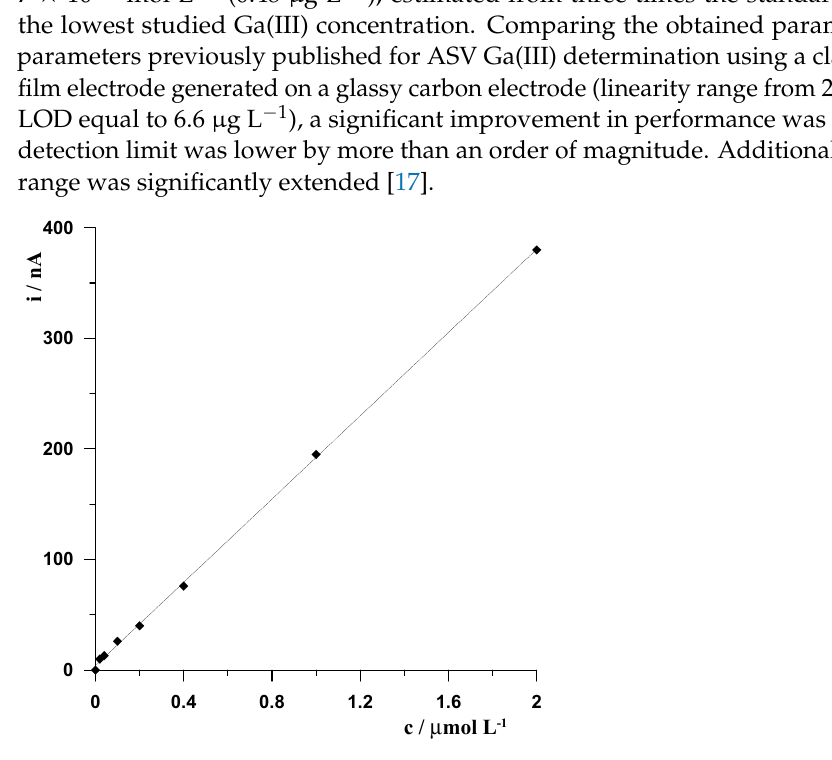
Figure 5. The calibration curve for the solution 0.1 mol L − 1 acetic buffer (pH = 4.6), 1.2 × 10 − 4 L − 1 Bi(III), and varying concentrations of Ga(III) in the range from 2 × 10 − 8 mol L − 1 to 2 × 10 − 6 mol L − 1